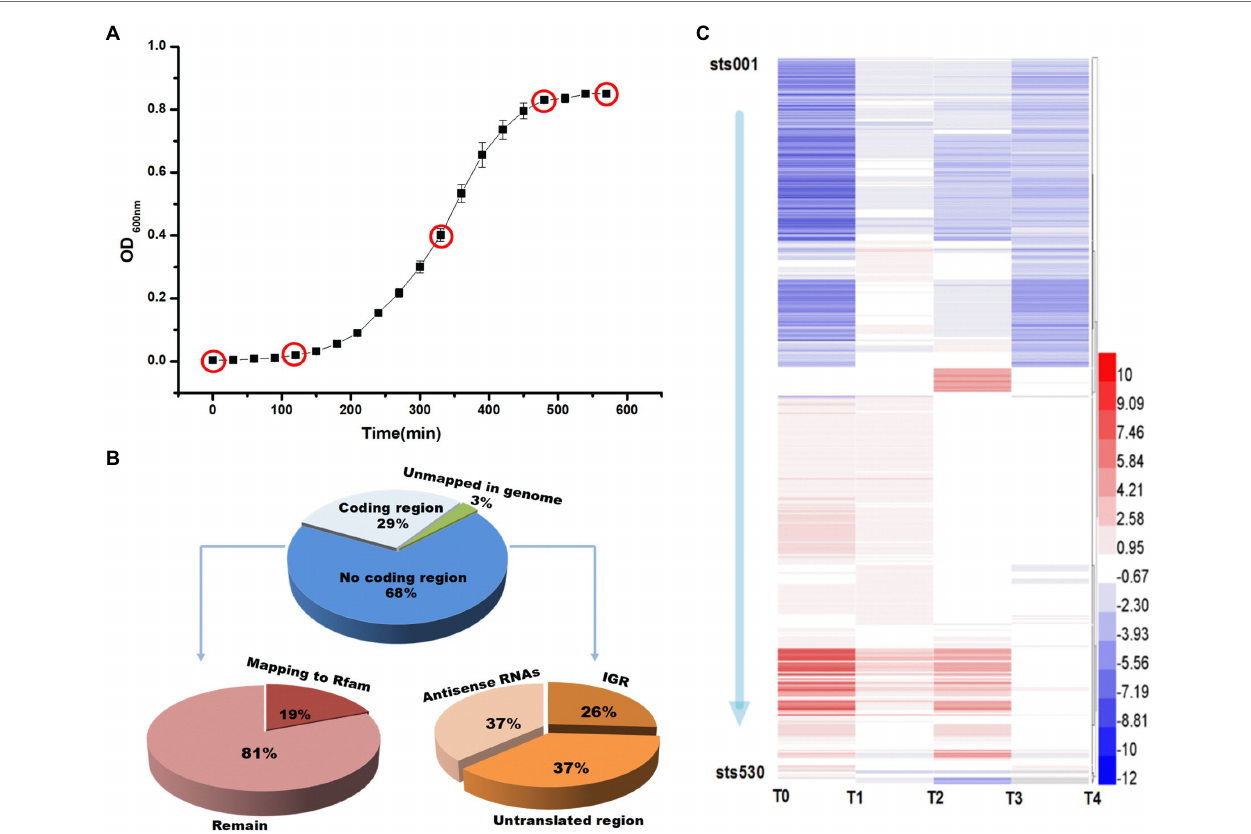
FIGURE 1 | (A) Growth curve and five sampling points during culture of ST-MZ-2. The x axis represents the culture time. (B) Pie charts of the classification of small RNA-sequencing reads. Percentages of all small RNA-sequencing reads that mapped to the genome in annotated or unannotated regions and relative percentages of the reads that mapped to unannotated regions. (C) Differential expression of 530 sRNAs. A heatmap showing the 530 sRNA genes identified as being differentially expressed in each growth phase. Blue: upregulated, red: downregulated. The color intensity is a measure of the fold change. T0, T1, T2, T3, and T4 indicate the early-lag, late-lag (early-exponential), mid-exponential, late-exponential, and stationary phases,